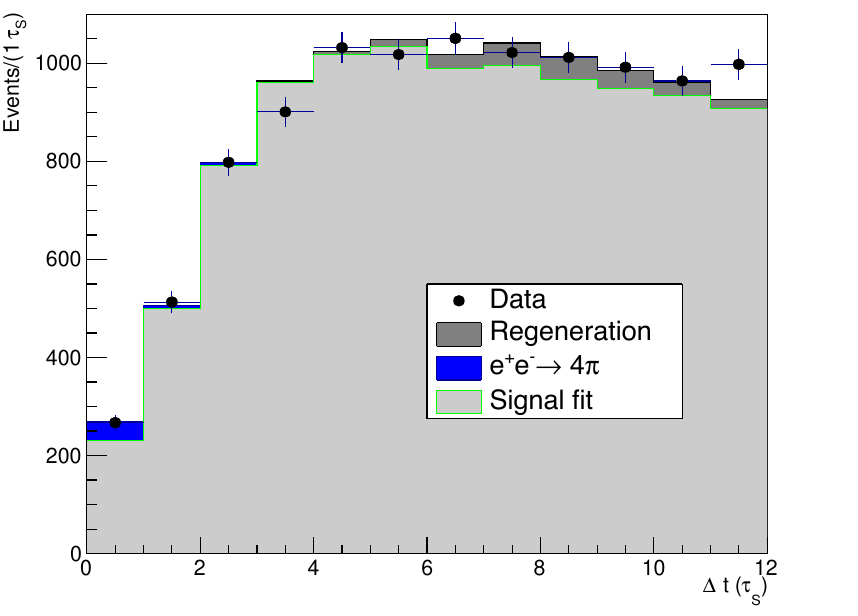
Figure 4 . Data and fit distribution for the ζ SL decoherence model with background contributions